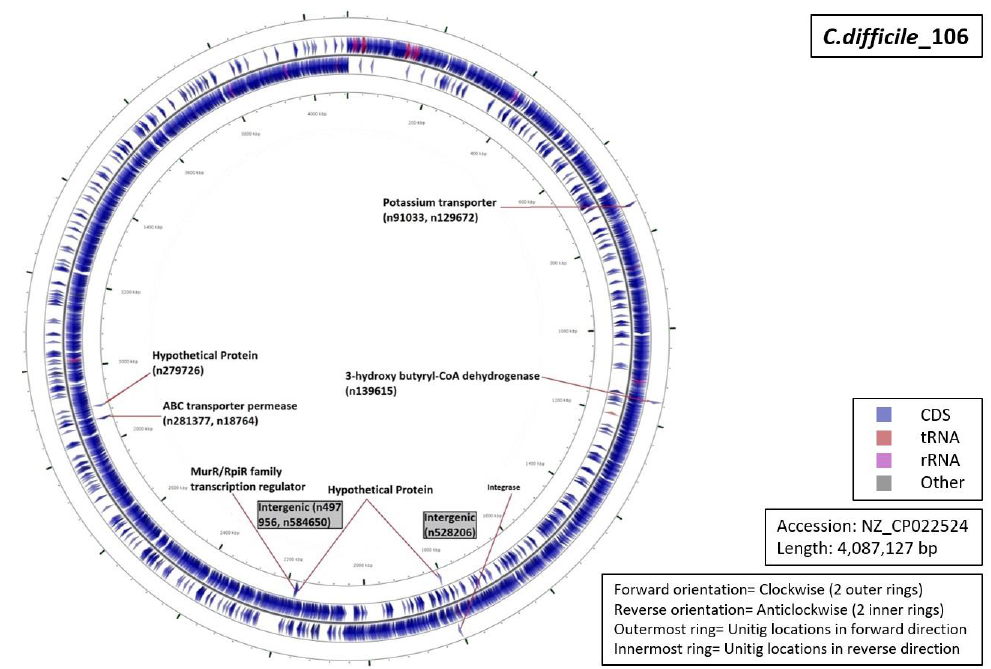
Figure 8. Functional annotation and location of DBGWAS markers on the reference genome of C. difficile RT078.